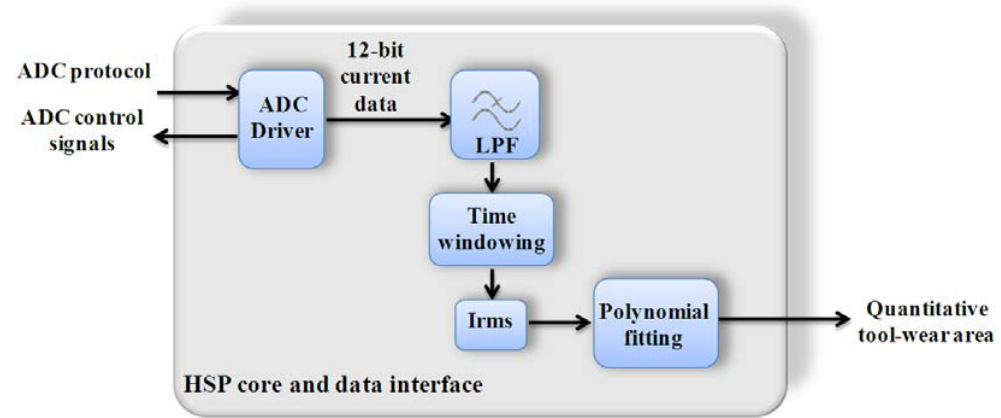
Figure 7. Block diagram for tool wear monitoring utilizing the HSP